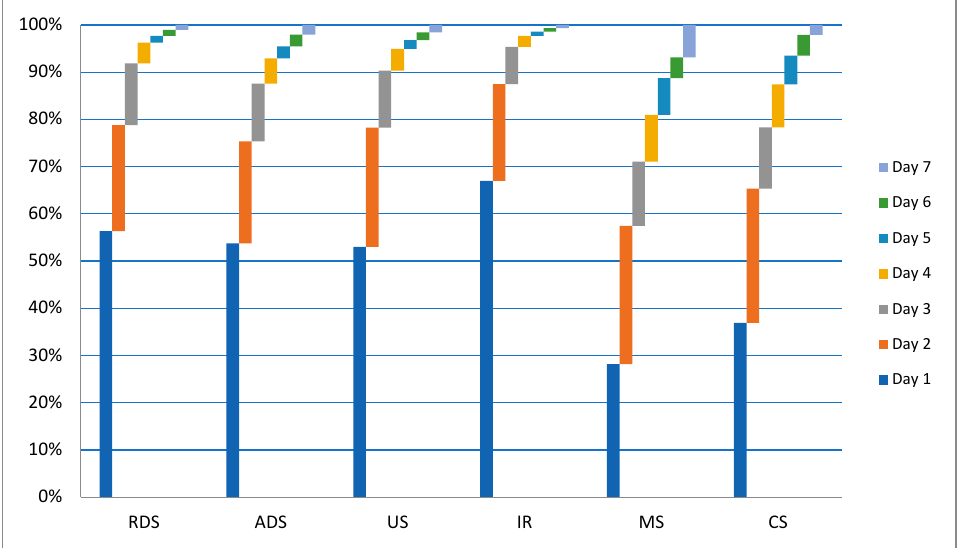
Figure 2. Ammonia emission dynamics. Intensity of daily emission rates as a percentage of the total emissions (100%). Unfertilized stubble-covered soil (CS), raw dairy slurry on the stubble (RDS), acidified dairy slurry on the stubble (ADS), irrigation immediately after RDS (IR), mineral nitrogen on the stubble (MS), raw dairy slurry applied under the stubble (US).